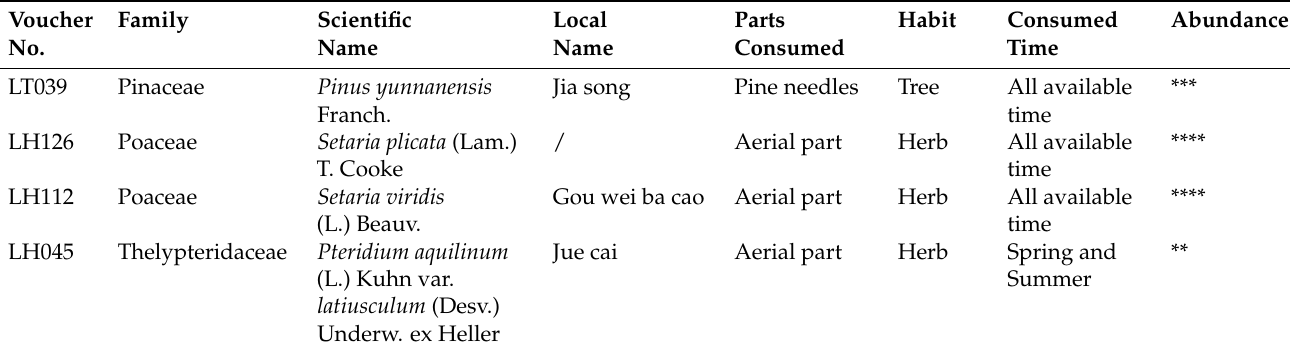
Figure 5. The pigsty built by farmers halfway up the hill. ( a ) The small-scale pigsty, which can hold up to 5 pigs; ( b ) the slightly large-scale pigsty, which can hold about 10 pigs. (Photo by Xingcen Zhao, August 2022, Photographed separately in Chongren and Zhongyuan villages). Table 4. Common plants for keeping pigsty dry.